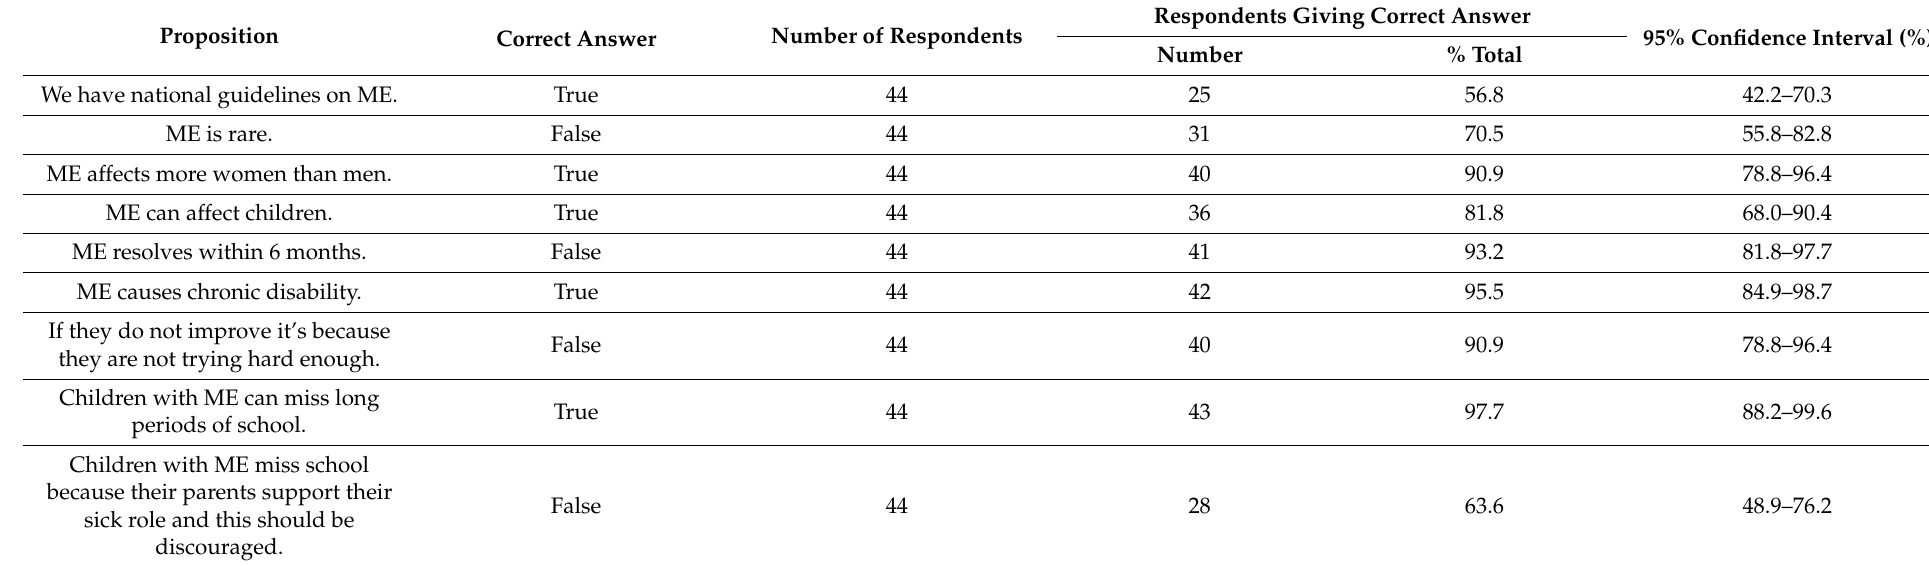
Table 4. Responses to propositions regarding the nature and epidemiology of